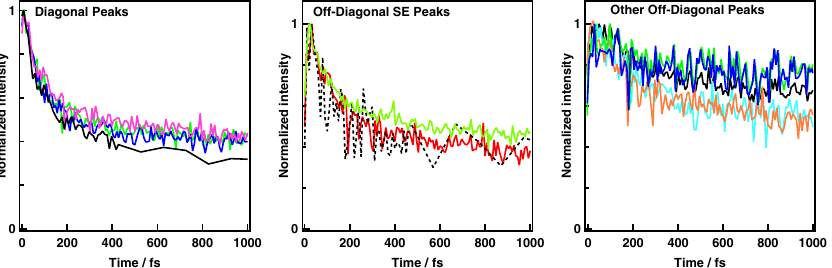
Figure 3. The fast (cid:25) 300 fs decays shown in diagonal (left) and o ff -diagonal stimulated emission peaks (middle) suggest exciton di ff usion or intraexcitonic